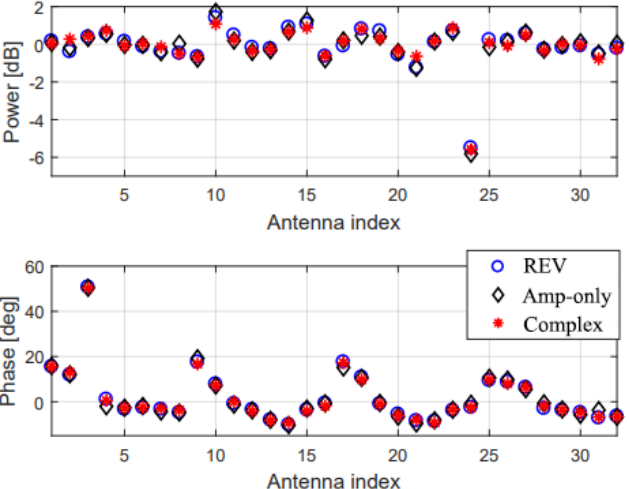
Figure 13. Array calibration results based on three methods with scattering parameters obtained via geometry configuration ( R = 1 m).